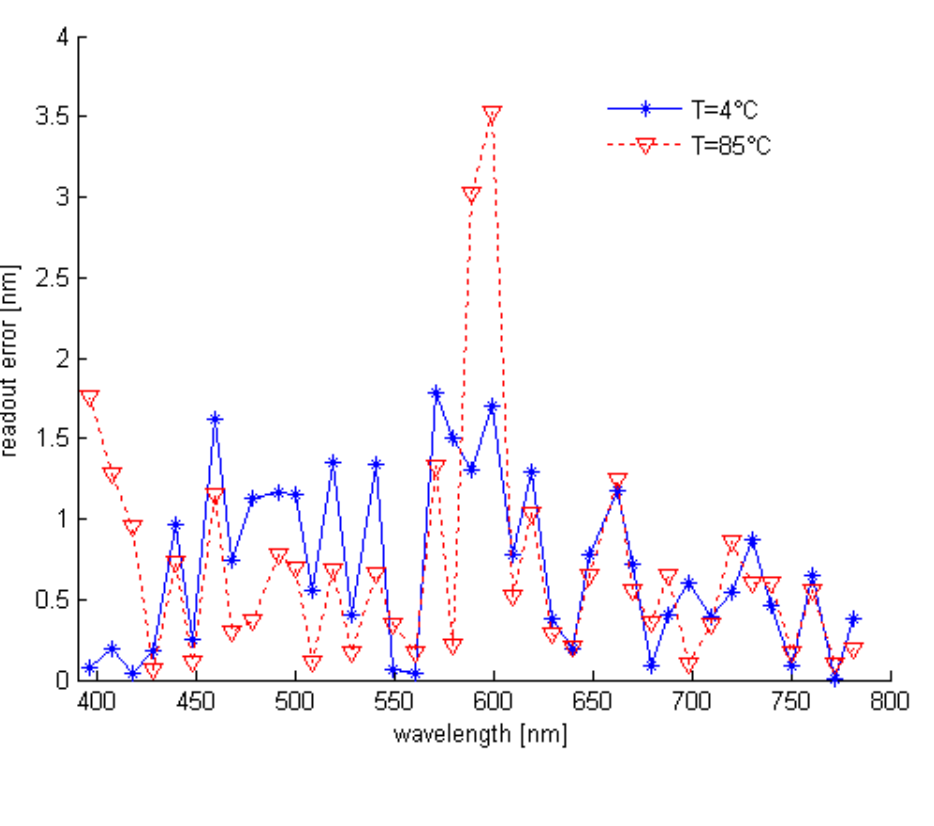
Figure 9. Readout error vs. wavelength at T = 4 and 85